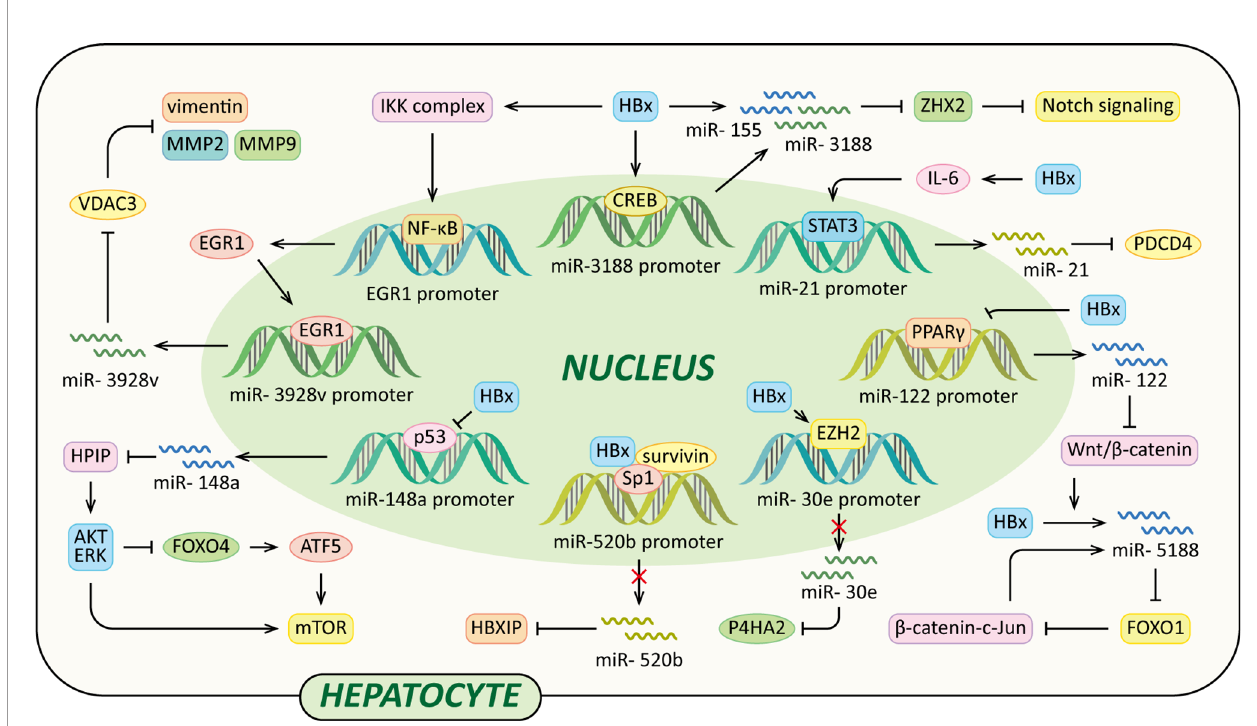
FIGURE 4 | Regulatory models of HBx and miRNAs involved in liver pathogenesis. The mechanisms involved in HBx and miRNAs are related to Notch signaling pathway, Wnt/ b -catenin signaling pathway, MMP, collagen deposition, HPIP/AKT/ERK/FOXO4/ATF5/mTOR signaling pathway and HBXIP, which result in cell proliferation, anti-apoptosis, c-Jun activation, VM, EMT, liver fi brosis and eventually